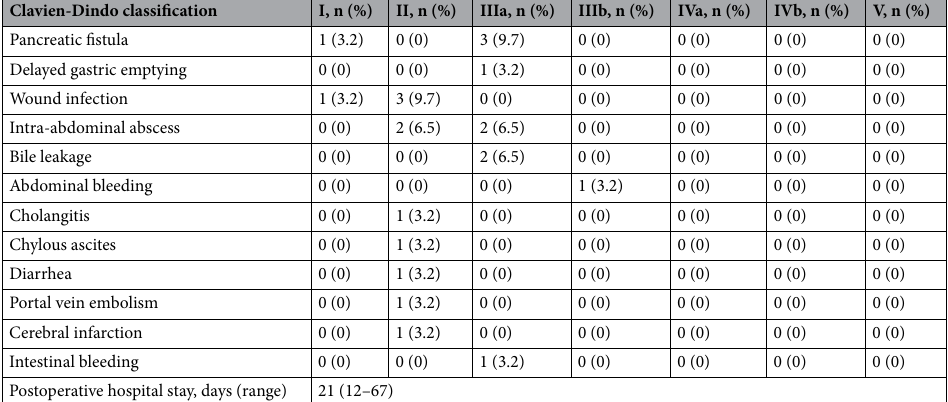
Table 4. Postoperative complications after resection (neoadjuvant therapy complete patients: n = 31). Postoperative complications were analyzed in 31 patients who underwent pancreatectomy after complete neoadjuvant therapy.